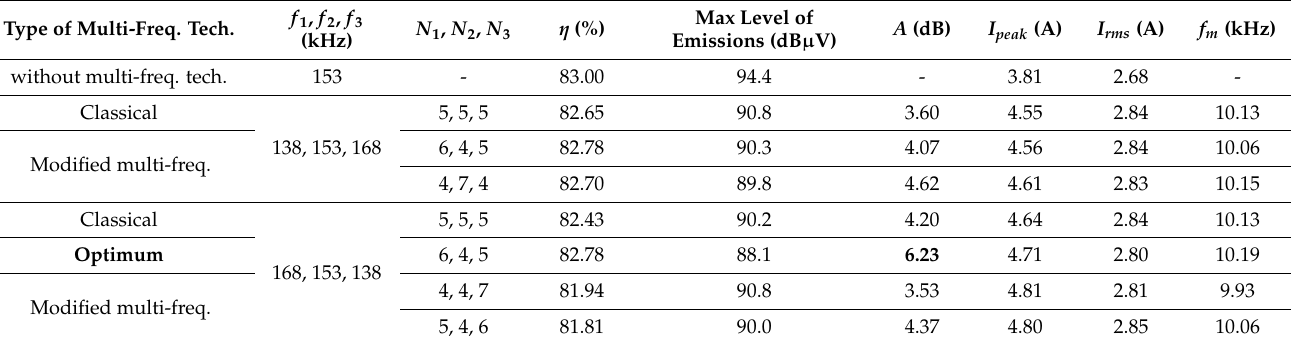
Table 3. The performance characteristics of the wireless battery charger without the multi-switching- frequency technique and with the technique (with different combinations of a number of pulses and the order of the switching frequencies). The load resistance is 12.6 Ω and the coils were aligned perfectly.